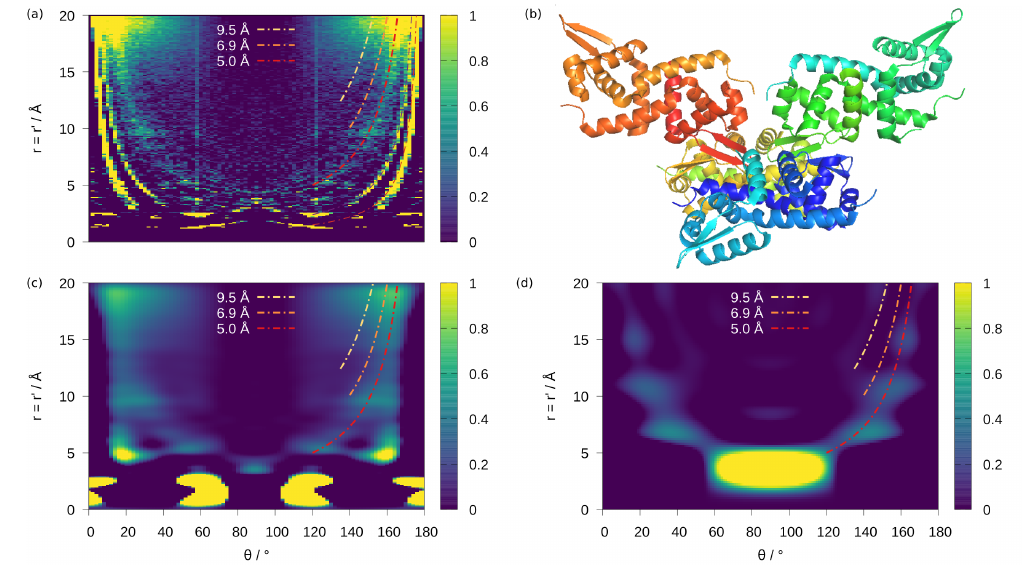
Figure 8. Comparison between PADFs of protein NolR from Sinorhizobium fredii (PDB code: 4OMZ) generated via different methods. ( a ) PADF generated from atomic model, no intensity scaling; ( b ) the ribbon diagram of the protein structure; ( c ) PADF generated from atomic model with lower angular resolution for comparison to PADF generated from the structure factors; and ( d ) PADF generated from the q -space correlation of the structure